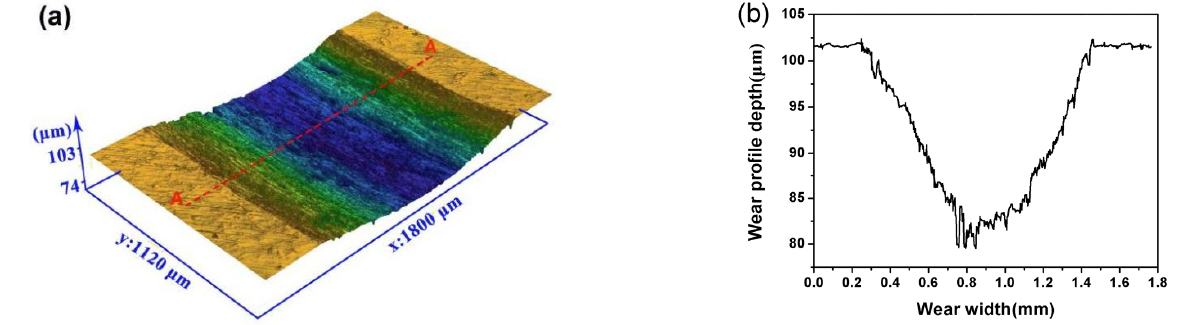
Figure 2. Typical 3D pro fi le ( a ) and 2D cross-sectional pro fi le ( b ) of the wear scar. X-ray di ff raction (XRD; D/MAX-RB RU-200B, Rigaku, Tokyo, Japan) was used to